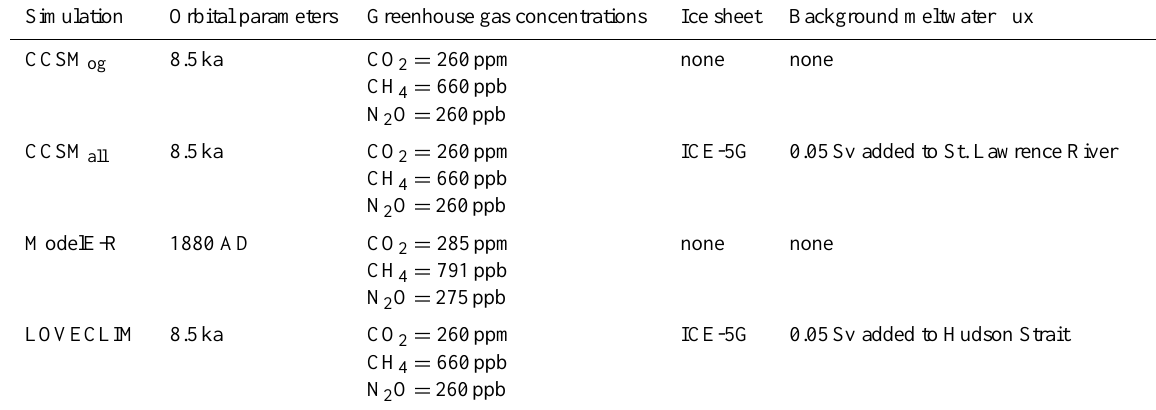
Table 2. Boundary conditions for control